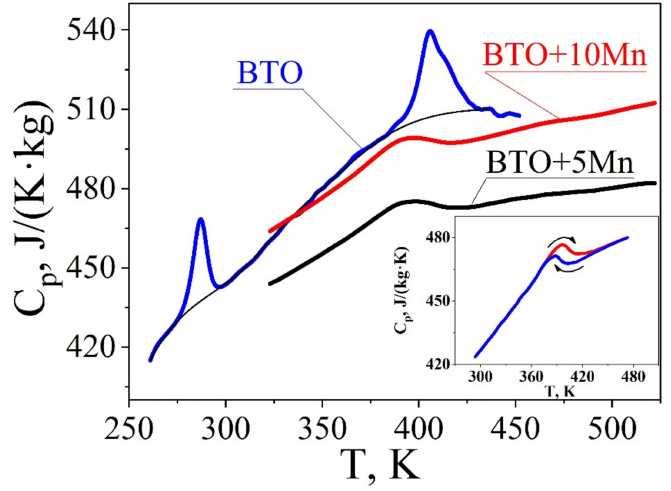
Figure 3. Specific heat capacity in pure BTO ceramics ( blue curve ) in comparison that of Mn-doped samples. The inset shows the Cp in heating and cooling cycles for lightly doped BTO (5%